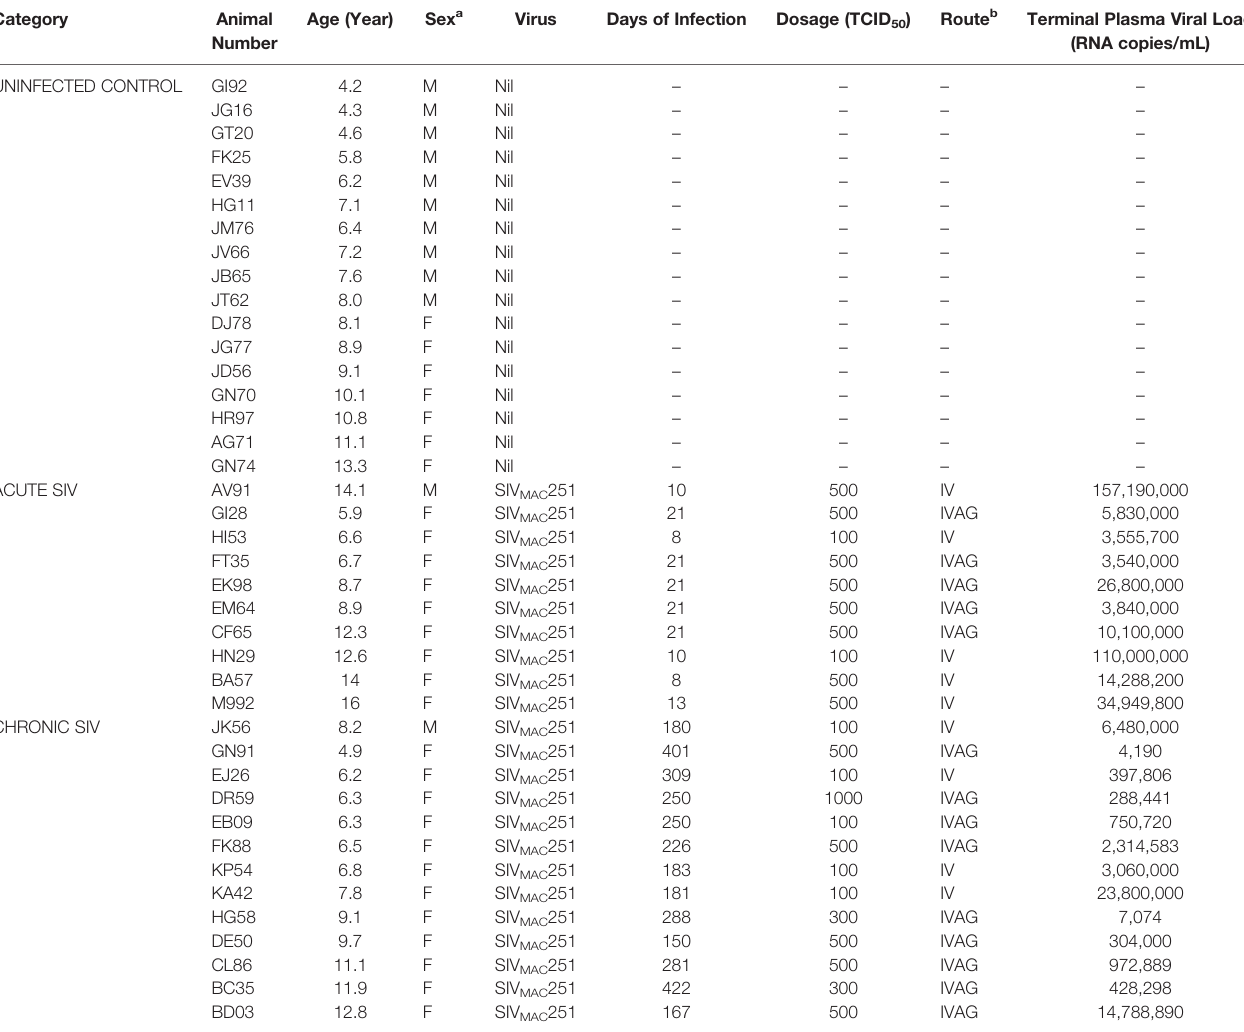
TABLE 1 | Cumulative List of Adult Rhesus Macaques